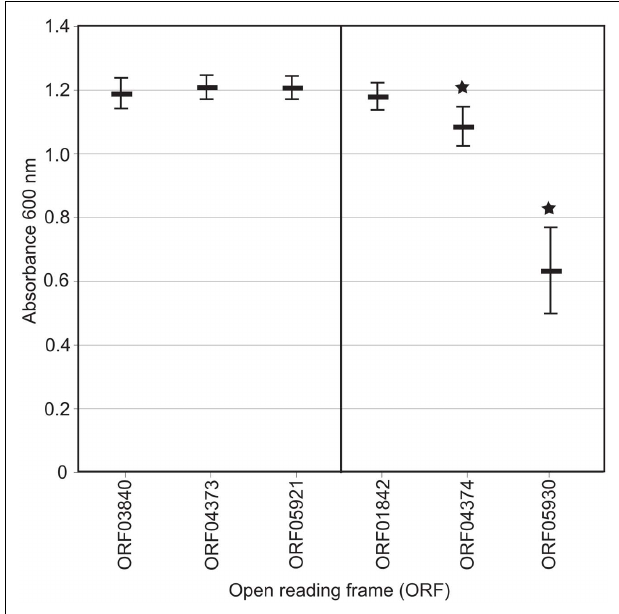
FIGURE 3 | Optical density of yeast cultures expressing putative effector genes (on right) and negative control genes (on left). Vertical bar represents distribution of values for 12 individual clones repeated in duplicate. * p = 7.9 e − 17 (ORF05930, t -test) and 3.3 e10 − 7 (ORF04374, t -test).